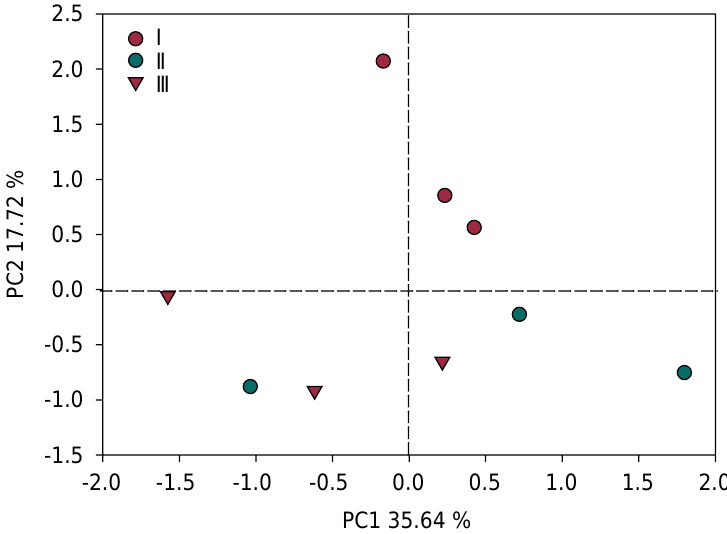
Figure 2. Principal component analysis (PCA) of the use on different carbon sources for soil microbial community. Treatment: Ⅰ, control; Ⅱ, pre-emergence after sowing herbicide spraying; Ⅲ, post-emergence stem, and leaf herbicide spraying.